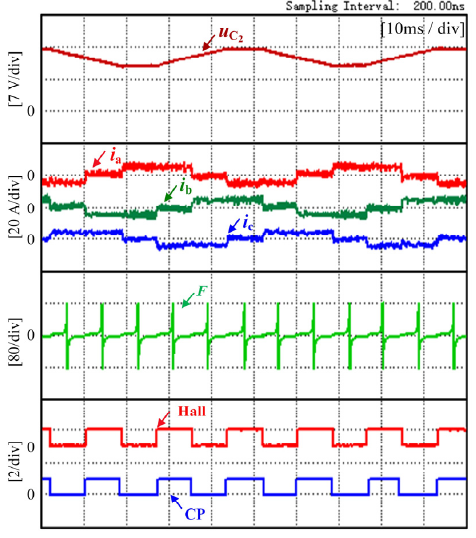
Figure 10. Experimental waveform under the condition of 300 r/min speed and 1 N·m torque.